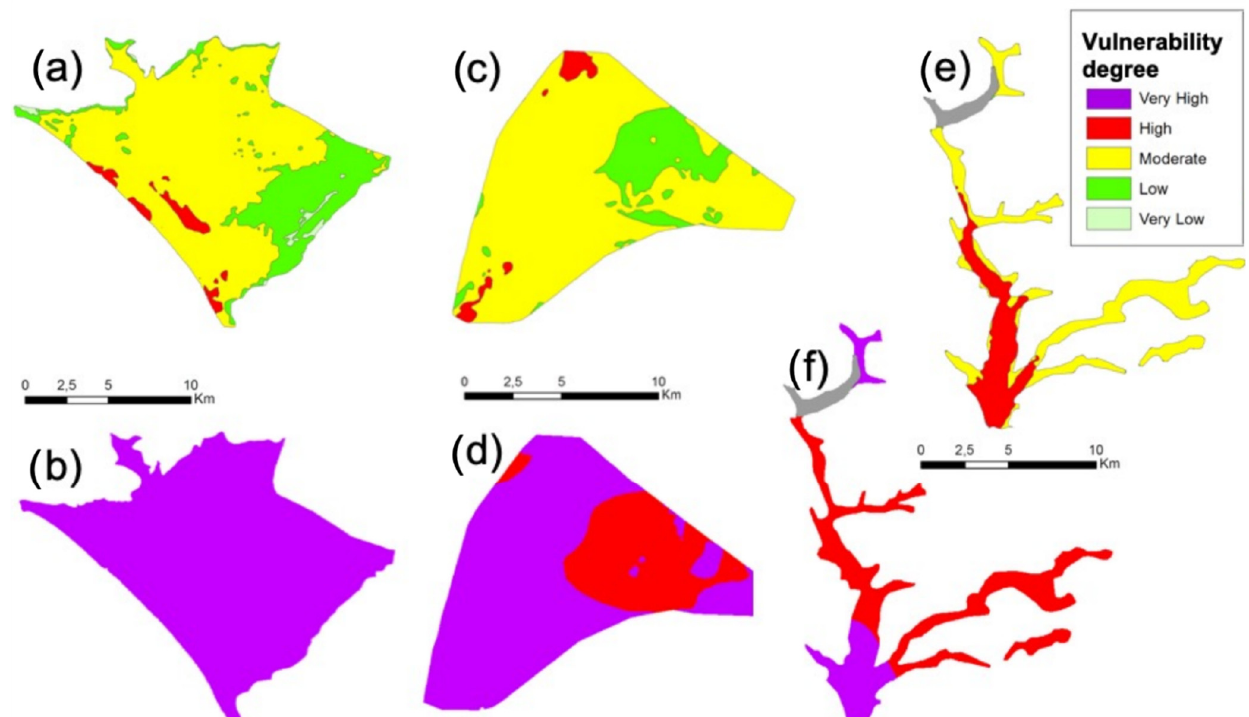
Figure 5. Vulnerability maps for ( a , b ) Garigliano River plain; ( c , d ) Campanian plain Acerra; and ( e , f ) Alento plain (in grey reservoir area), mapped using the original DRASTIC ( a , c , e ) and AVI ( b , d , f ) methods [11,14].